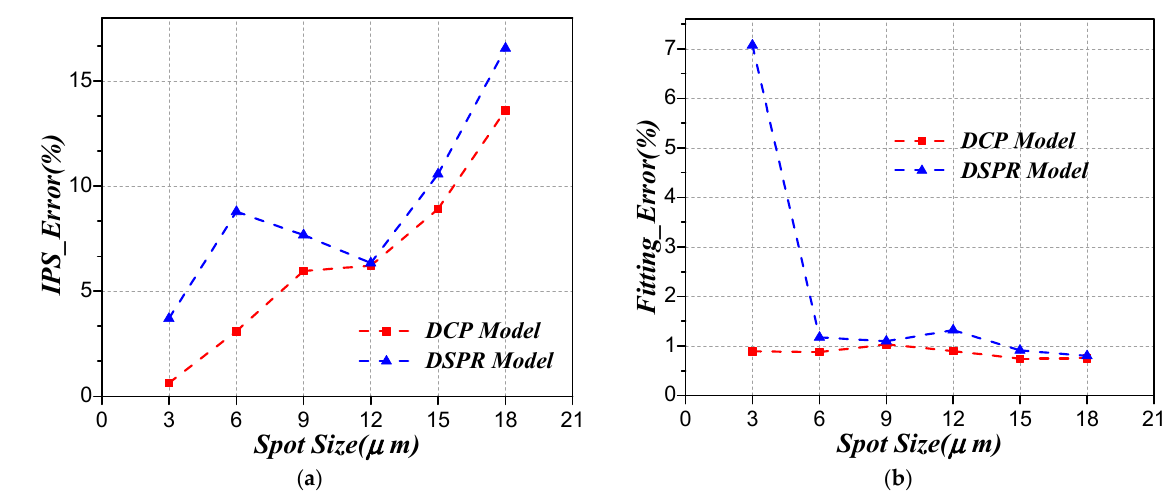
Figure 5. IPS calculated error and fitting error of simulated data for different models: ( a ) IPS calculated error versus the size of simulated beam spot; ( b ) fitting error versus the size of simulated beam spot. Table 2. IPS calculated error and fitting error of different size of simulated beam spot.